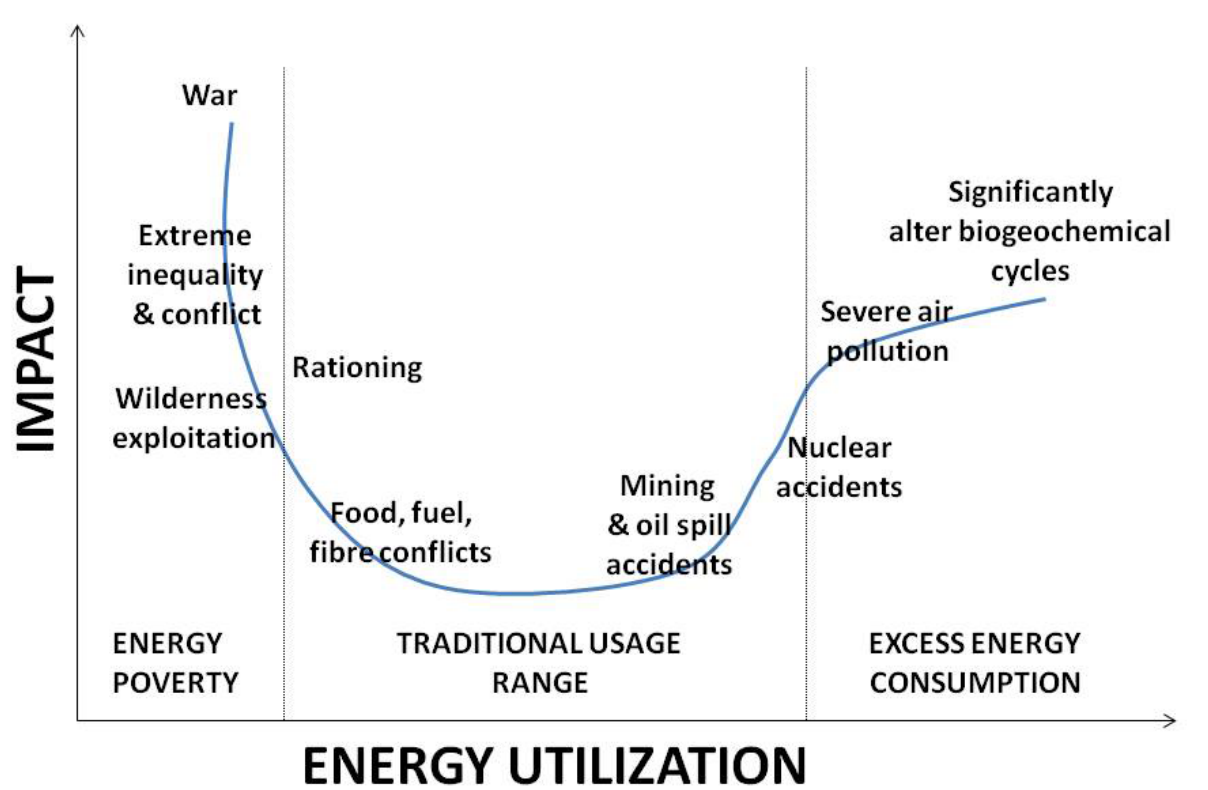
Figure 2. An energy sufficiency-efficiency cost curve. A schematic comparison of costs of energy poverty and excess energy consumption. The rough U-shape is characteristic of systems with excess impacts related to extremes of resource access and use. An associated aspect of the process of defining a regime of ‘wise use’ of resources is the role of efficiency relative to robustness of the system. A useful alternate representation is to place efficiency (“streamlining”) and diversity (“robustness”) as extremes on a single axis 38